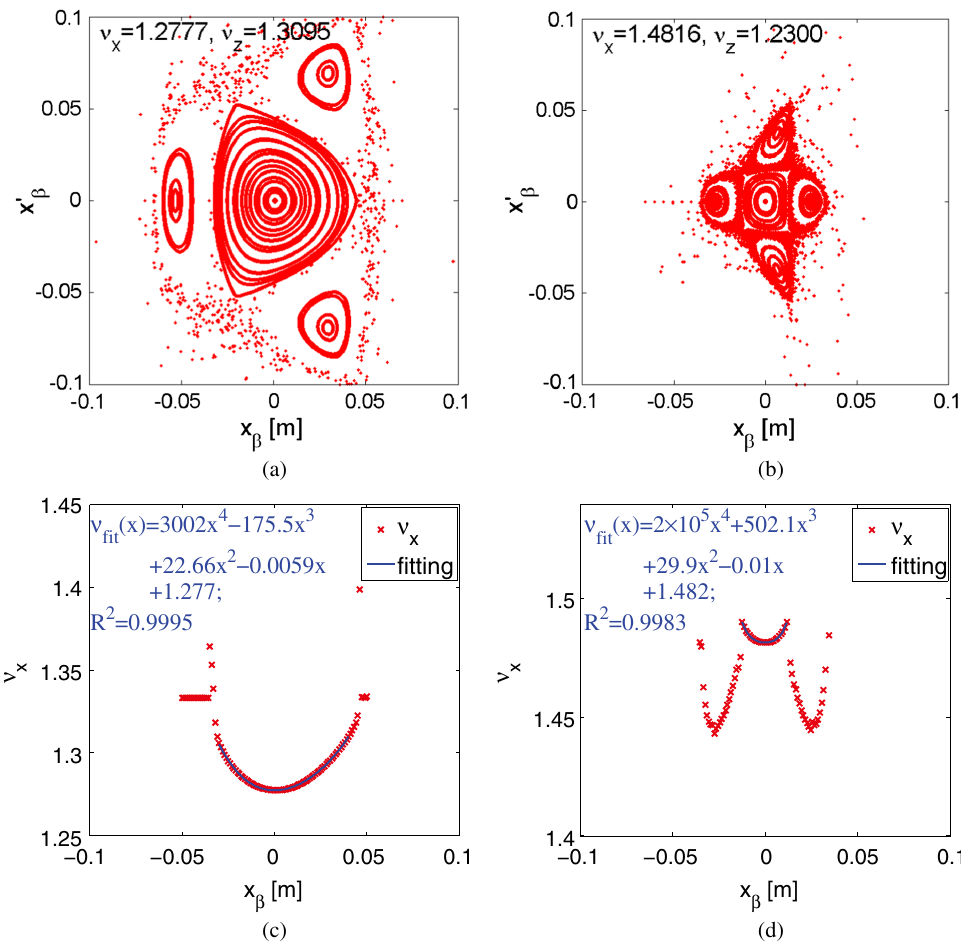
¼ 4 resonance line. Plot (b) shows that of 4 ν ¼ 6 x x